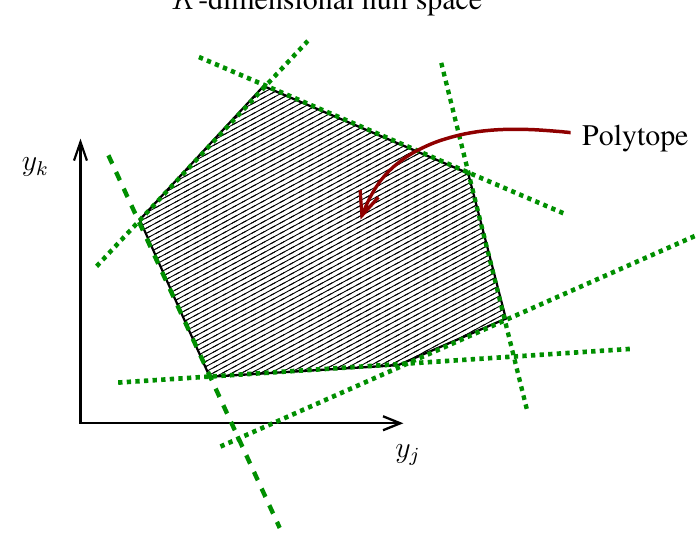
Figure 4. A cartoonish representation of the polytope in a K -dimensional null space spanned by y -coordinates. Here, the green dashed lines represent the set of hyperplanes (21) enclosing the